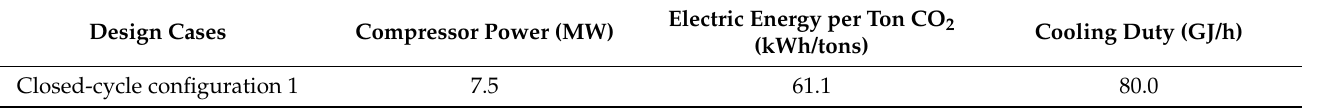
Figure 12. Heat curve for the heat exchanger. Hot composite/CO 2 stream (red) and cold composite/NH 3 (blue). Table 7. Results for the closed-cycle configuration 1.